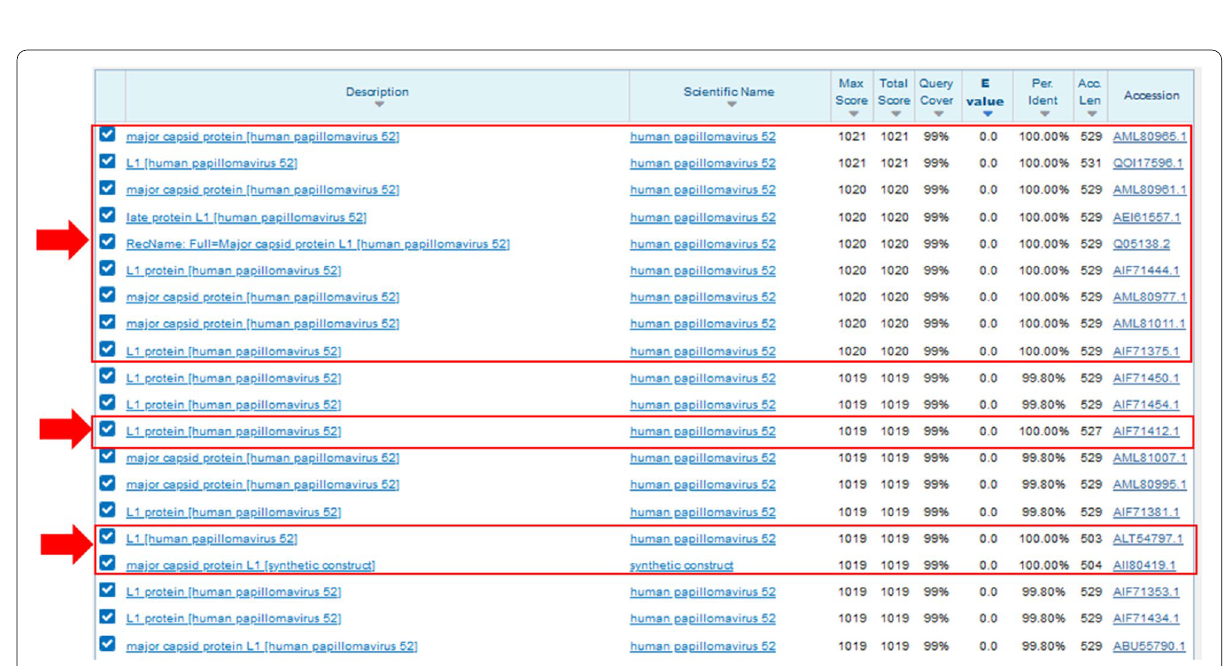
Fig. 11 The BLAST analysis for aa L1HPV52